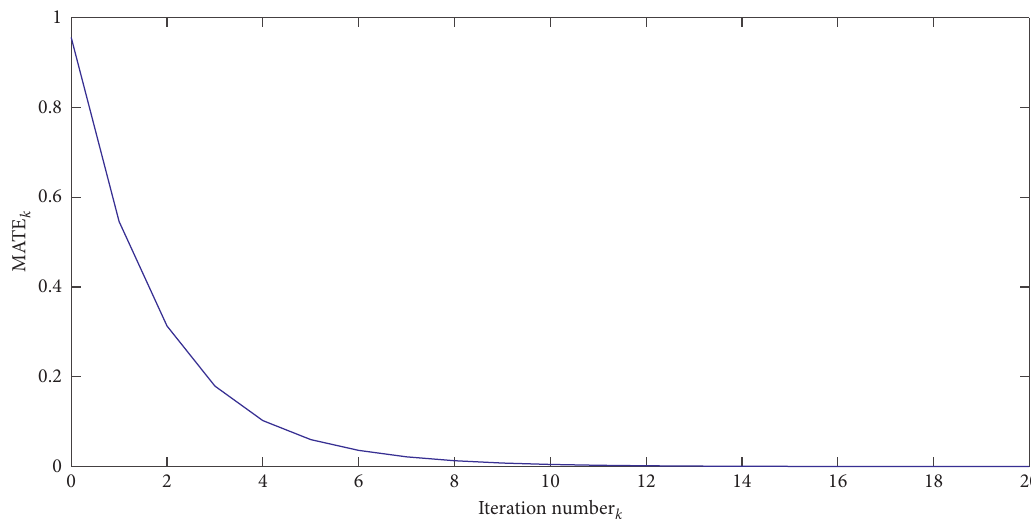
( n , n ) at k � 3 , 5 , 7 , 20. k 1 2